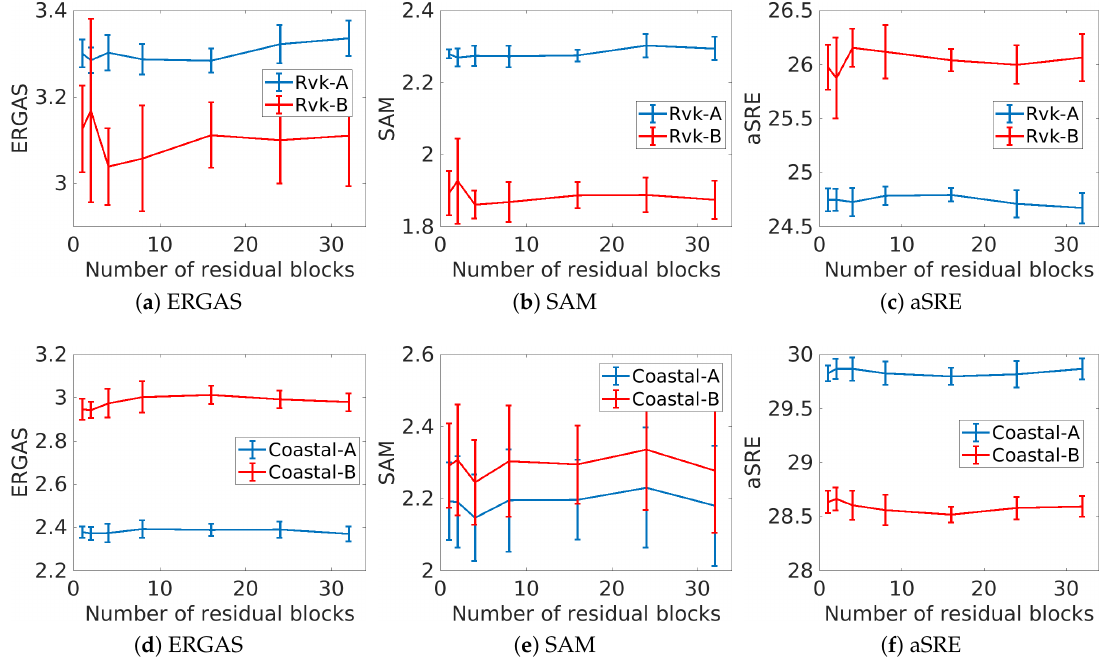
Figure 7. Values of the quality evaluation metrics as a function of the number of residual blocks for the Coastal and urban Rvk datasets. The network was trained on the A image and tested on A and B. aSRE is the average SRE of the bands and is given in dB and SAM is given in degrees.